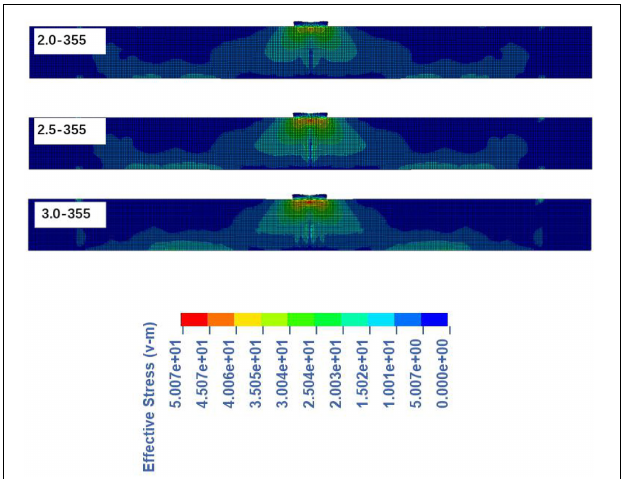
FIGURE 8 | Equivalent Stress field of ordinary beam under different impact heights.